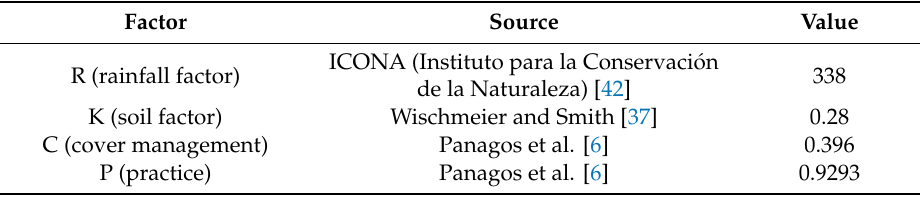
Table 1. The Revised Universal Soil Loss Equation (RUSLE) parameter values